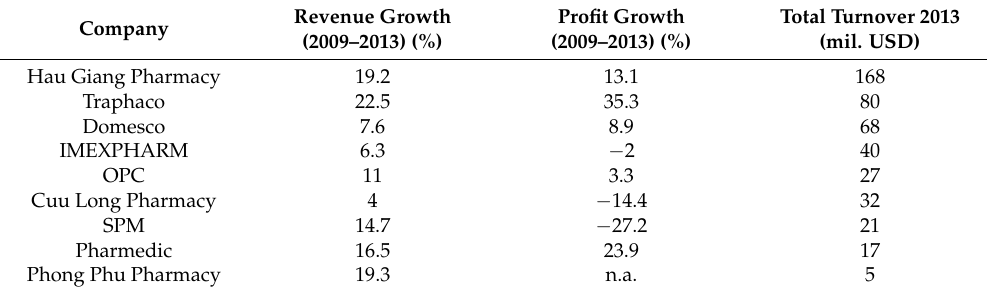
Table 2. List of biggest domestic pharmaceutical